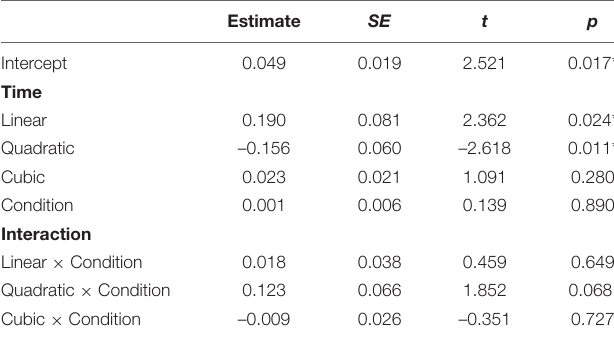
TABLE 2 | Results of growth curve analysis on SR-T3 target ratios and CR-T2 competitor ratios when hearing SR-T3